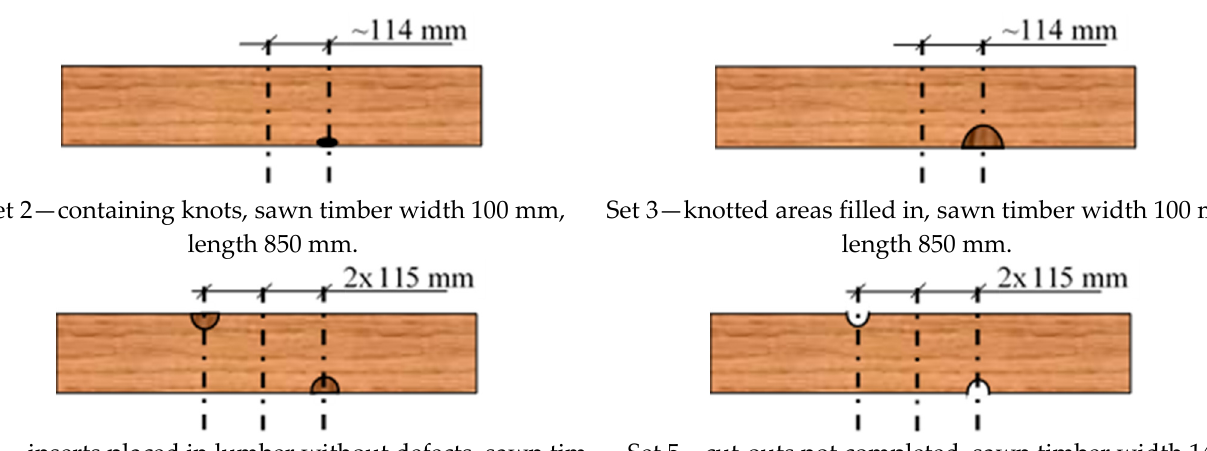
Figure 1. Surface appearance of lumber without and with defects.